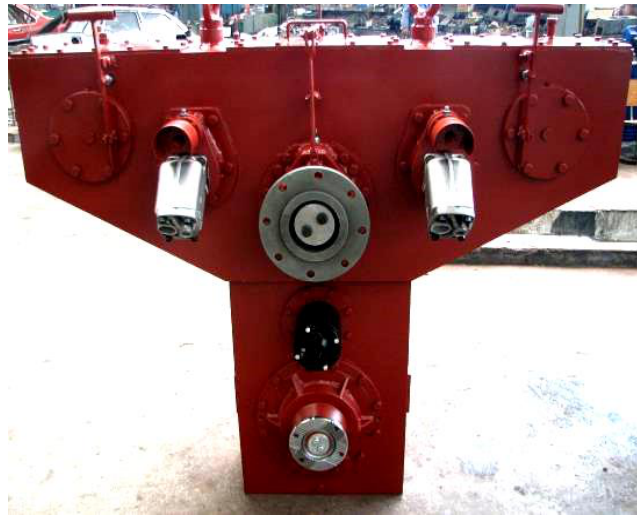
Figure 17. New adder box, welded version.